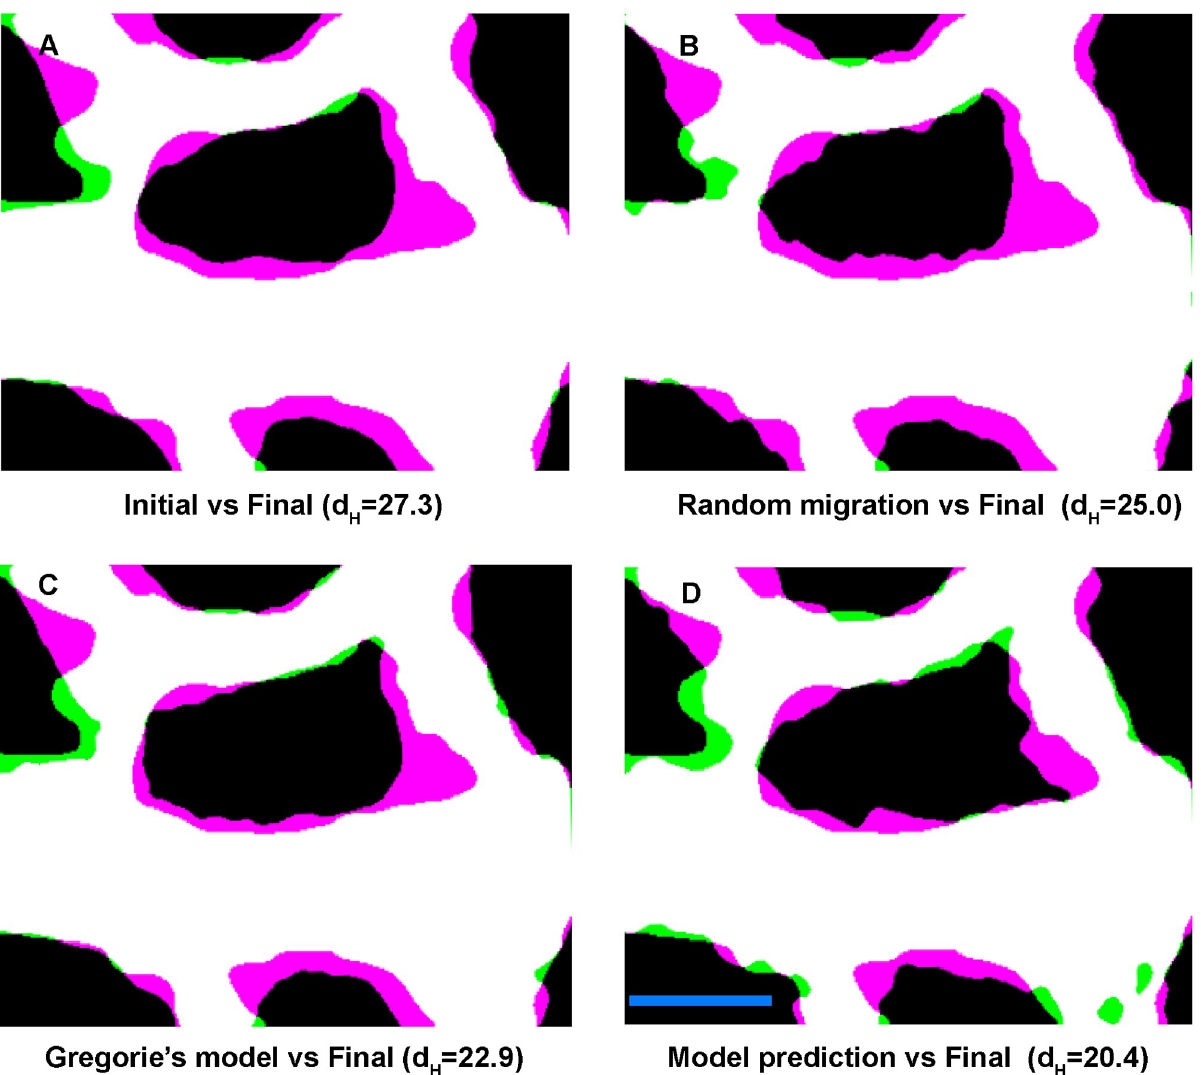
Fig 8. Assessment of the model. A) Change in geometry due to remodelling when overlaying the real initial and the real final shapes (after four hours) of the vessels without computational simulation. B) Error in the final shape with a model based on random migration. C) Overlay of the final predicted shape based on the Gre ´ gorie’s model. D) Overlay of the final predicted shape using our model. Similarity of the images can be compared by their d H (with smaller d representing a better prediction). The parameters used for this model: α = 100, β = 40, z = 0, ω = 20, η = 0.1, κ = 20, β H and κ av = 10. Scale bar = 100 μm